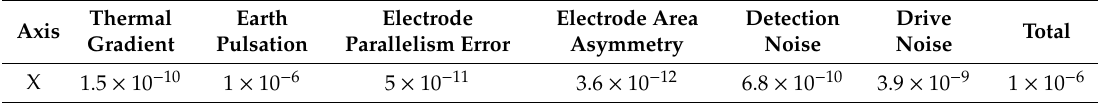
Table 5. Acceleration noise act on the TM (unit: m/s 2 /Hz 1/2 ).